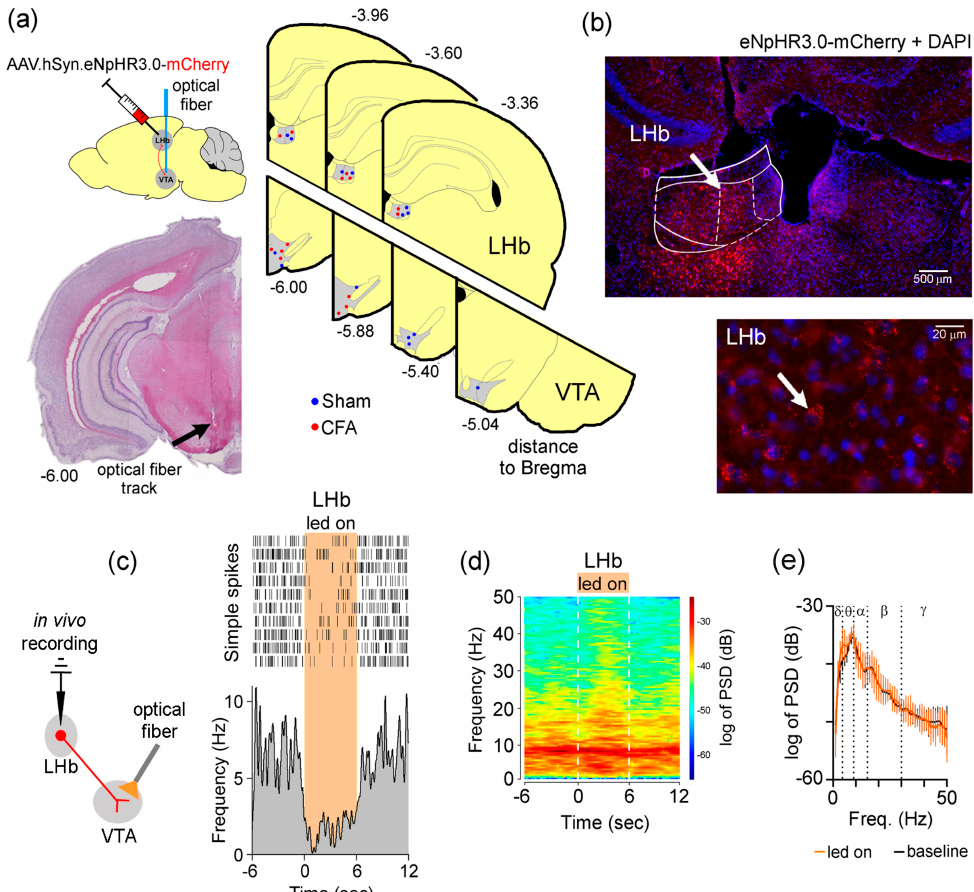
Figure 2. Optical fiber location, virus expression in LHb neuron projecting to VTA, and functional electrophysiological validation of the selective optogenetic neuromodulation protocol. ( a ) Top left panel illustrates the experimental paradigm for optogenetic viral particles infusion in the LHb and optical fiber implantation in the VTA, and bottom left panel represents an example of a histological brain section consisting the optical fiber tip location in the VTA. Right coronal diagrams illustrating the virus infusion locations in the LHb (top panel) and the optical fiber locations in the VTA (right bottom panels). Top and bottom numbers represent the anterior-posterior distance (in millimeters) relative to bregma cranial point. Sham-treated rats illustrated by blue dots, and CFA-treated rats by red dots. ( b ) Coronal slice example of the LHb transfected area (top panel), and magnification of the LHb area (bottom panel). Red fluorescent protein (mCherry) labeling indicates eNpHR3.0 LHb transfected neurons. Blue dots represent the DAPI, DNA-labeling as nuclear counterstain. ( c ) Strategy used for optogenetic inhibition of LHb glutamatergic neuron terminals into the VTA (left panel). Effects of optogenetic photoinhibition in the background activity of a LHb eNpHR3.0-expressing unit. Vertical orange rectangle indicates the period of light photoinhibition. The recorded unit exhibited significant inhibition of their discharge activity during the light delivery period. ( d ) Full spectrogram of raw LFP activity recorded in the LHb, and ( e ) the corresponding power spectral